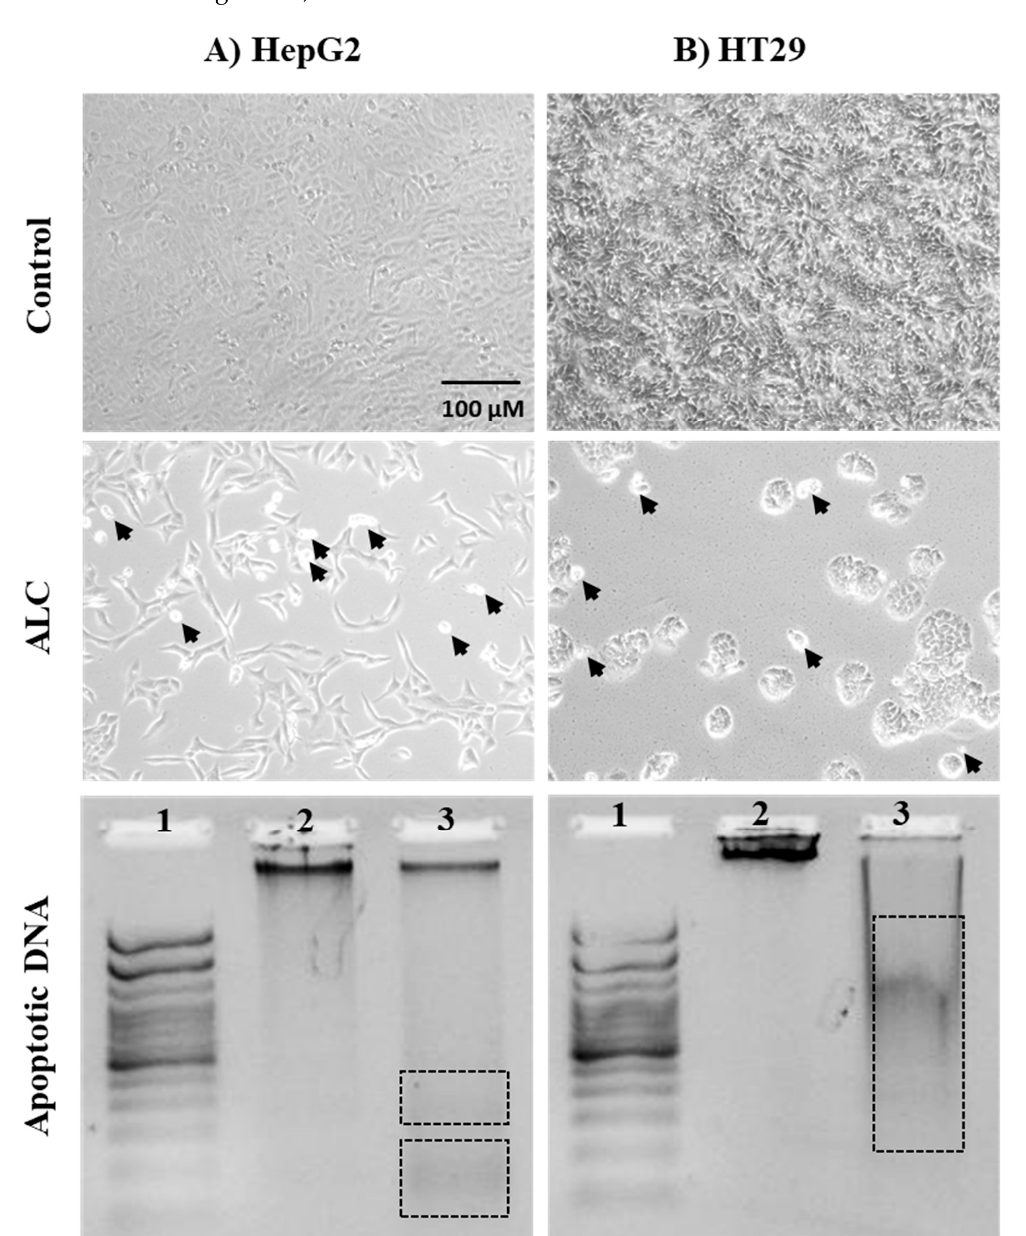
Figure 4. The effect of ALC treatment on cell morphology and DNA fragmentation in HepG2 and HT29 cells. ( A ) HepG2 cells and ( B ) HT29 cells. Cells were treated with their IC 50 concentrations for 48 h and images of cells were captured under a brightfield microscope. Apoptotic cells are marked by arrows. Gel electrophoresis of apoptotic DNA collected from each cell was performed after treatment with ALC at IC 50 concentrations for 48 h, ( 1 ) Kb DNA ladder, ( 2 ) control cell, ( 3 ) cell treated with ALC. Apoptotic DNA fragmentation is marked by rectangles.